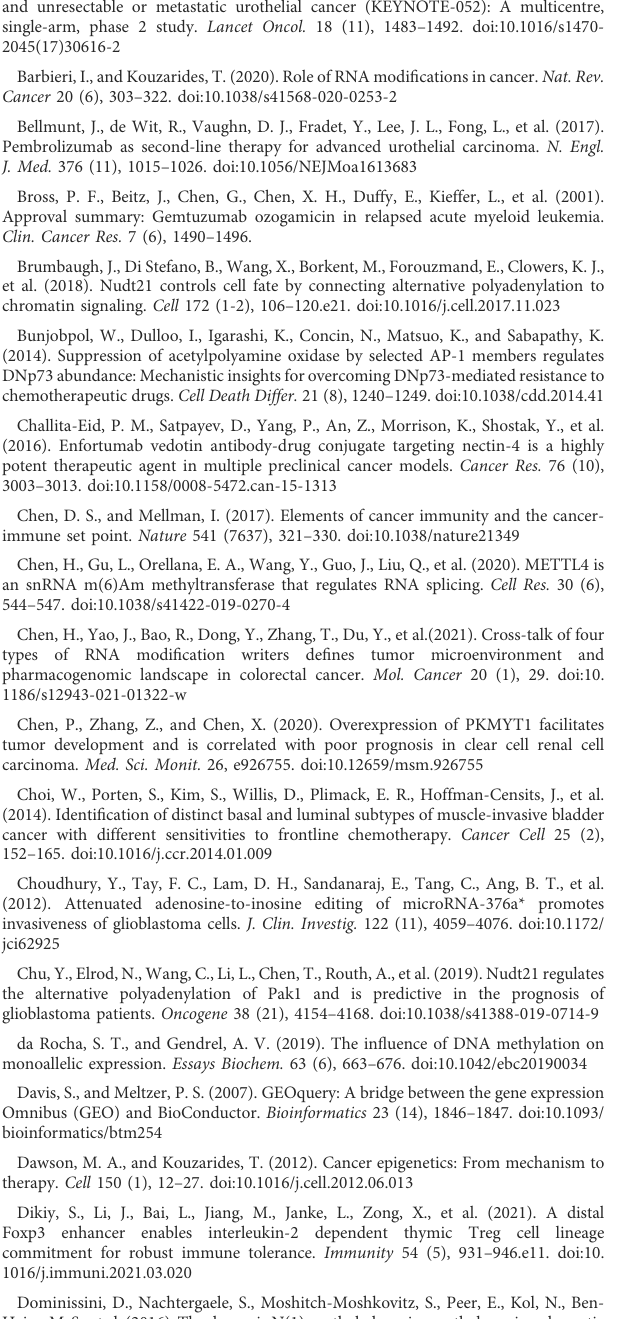
associated genes between multiple tumors and normal samples. The colors from purple to red represented the fold change between tumor and normal tissues. (D) Heatmap revealing RMS model-associated genes that have inhibitory or activated functions in multiple cancers. Pathway_A (Red) andpathway_I(Blue)representedtheproportionoftumorinwhichpathways may be activated or inhibited by model-related genes, respectively. Abbreviation: Hete Amp, heterozygous ampli fi cation; Hete Del, heterozygous deletion; Homo Amp, homozygous ampli fi cation; Homo Del, homozygous